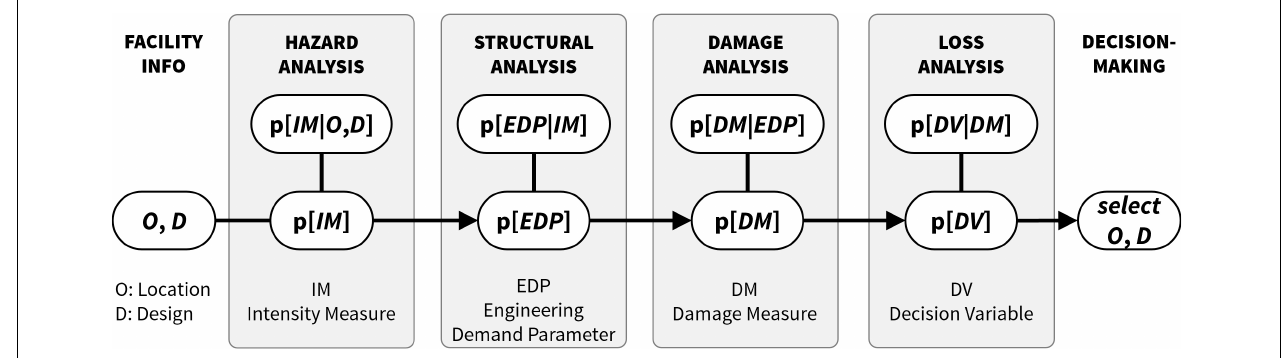
FIGURE 1 | Framework for performance-based engineering (after Porter,